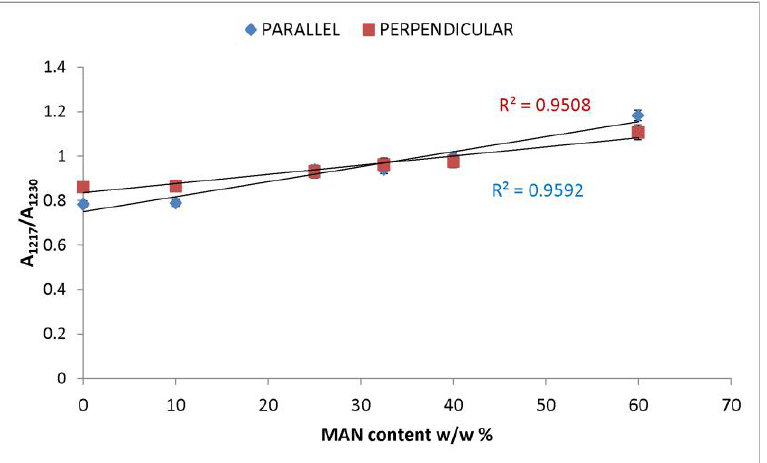
Figure 6. Trend of the IR A 1217 /A 1230 absorbance ratio (obtained from the parallel and perpendicular spectra) as a function of the weight gain (i.e., MAN content w / w